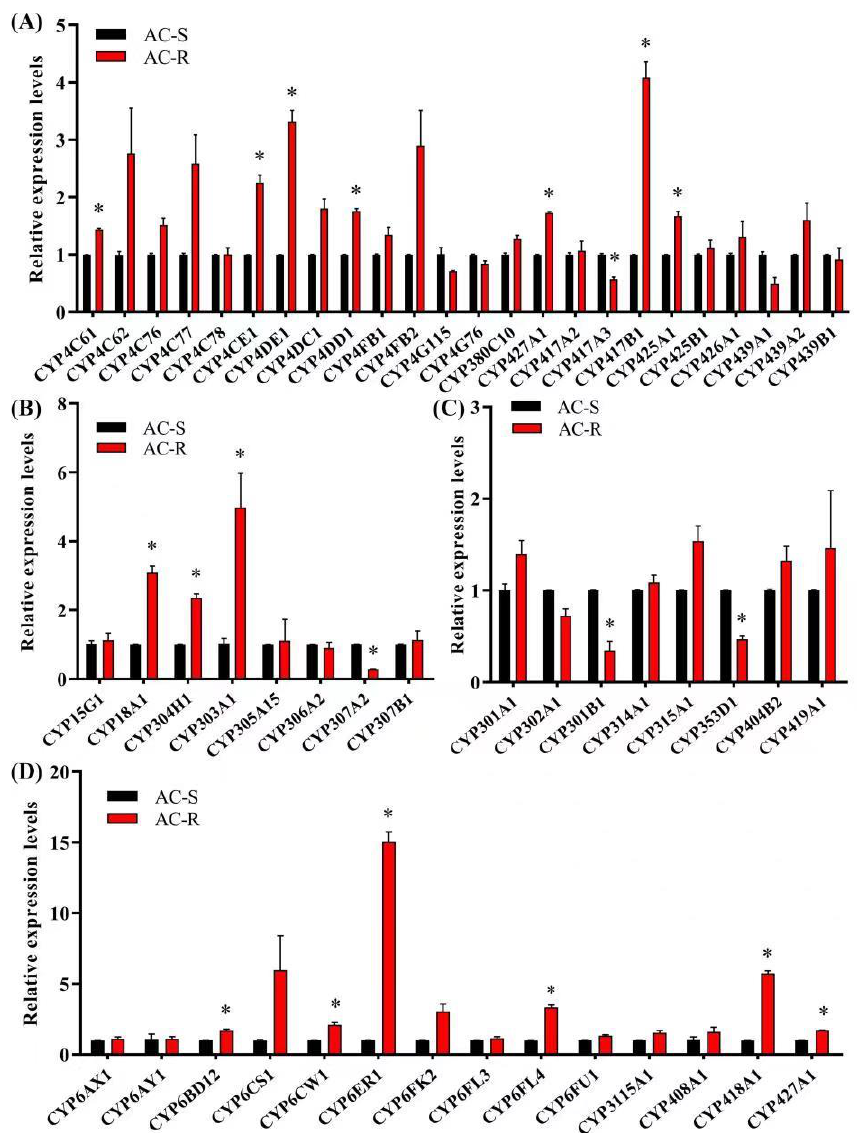
Figure 2. Relative expression levels of 54 P450 genes in AC-R (G 28 ) compared to AC-S. ( A ) Relative expression levels of P450 genes from CYP4 clade. ( B ) Relative expression levels of P450 genes from the CYP2 clade. ( C ) Relative expression levels of P450 genes from the mitochondrial clade. ( D ) Relative expiration levels of P450 genes from the CYP3 clade. * The asterisk indicates significant differences as determined by Student’s t -test ( p < 0.05).